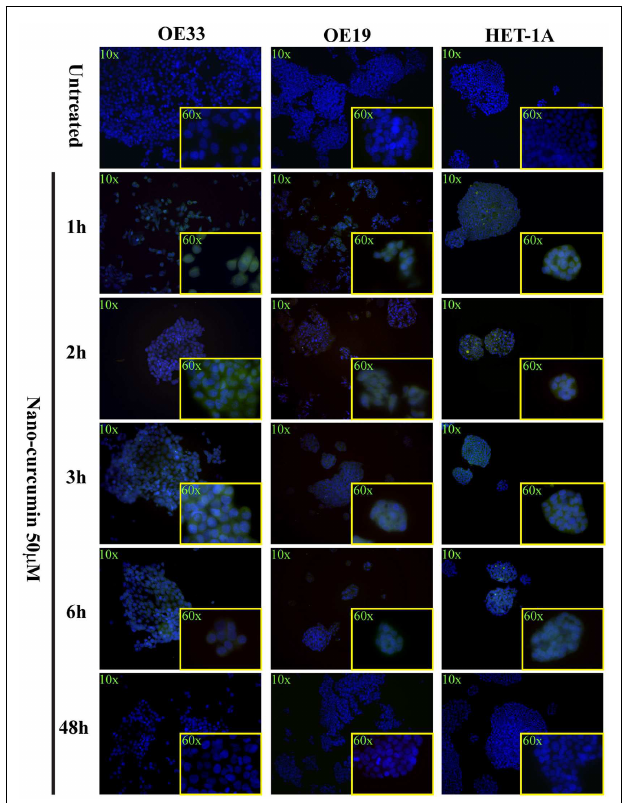
FIGURE 1 | Uptake of nano-curcumin in EAC cell lines compared to normal esophageal cell lines. Fluorescence microscopy analysis shows that nano-curcumin, which is green autofluorescent is rapidly (within 1h) taken up by cells.The uptake seems to increase with time and it is still observed after 6h. Micrographic pictures are representative of three independent